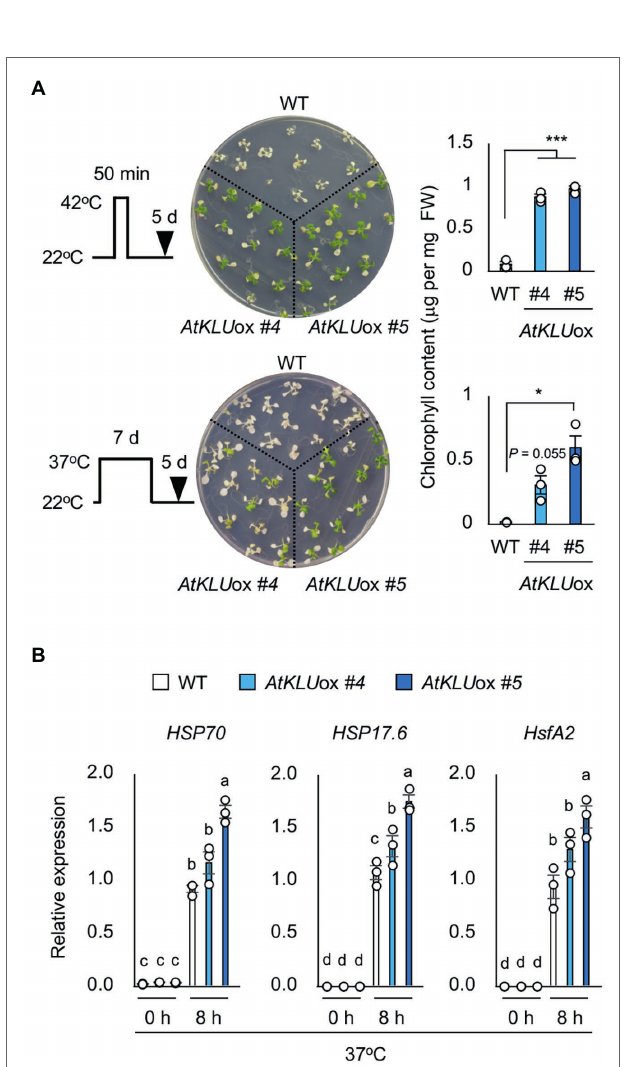
FIGURE 2 | *** p < 0.001). (C) Expression profiles of osmo-responsive marker genes in WT and AtKLU ox plants under normal (0 h) and acquired osmotic stress (100 mM NaCl for 7 days followed by 750 mM sorbitol for 8 h) conditions; expression levels were determined by quantitative real-time PCR relative to those of Actin2 . Bars labeled with different letters differ significantly ( P < 0.05, one-way ANOVA with post hoc Tukey HSD test, mean ± SE, n = 3).